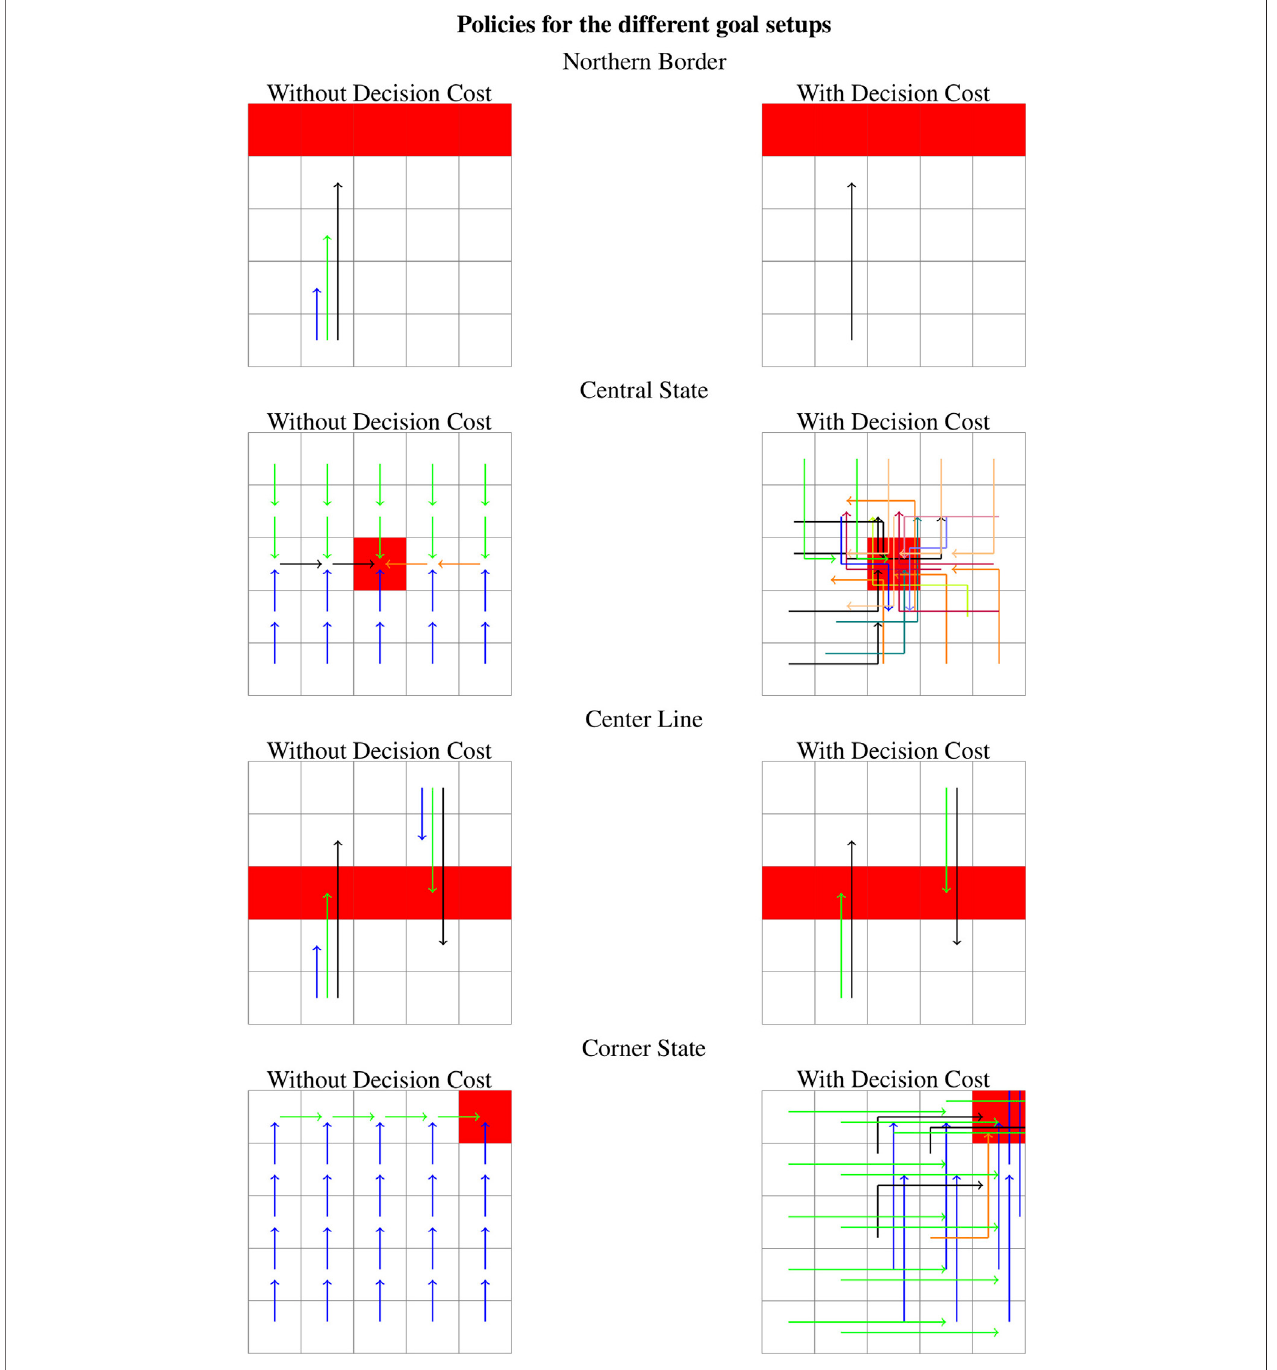
FIGURE 2 | Resulting policies for the different goal sets with and without decision cost. Different colors denote different actions (basic actions or scripts). Thus all states with a differently colored action are the ones that need to be distinguished while the states with the same color can be interpreted by the agent as a single super- state which does not need to be further